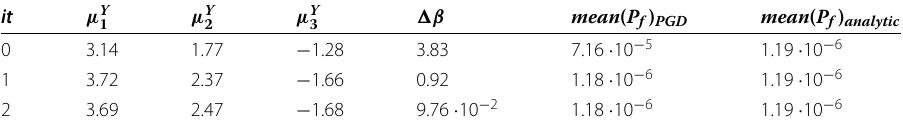
(cid:5)β as well as the failure probability